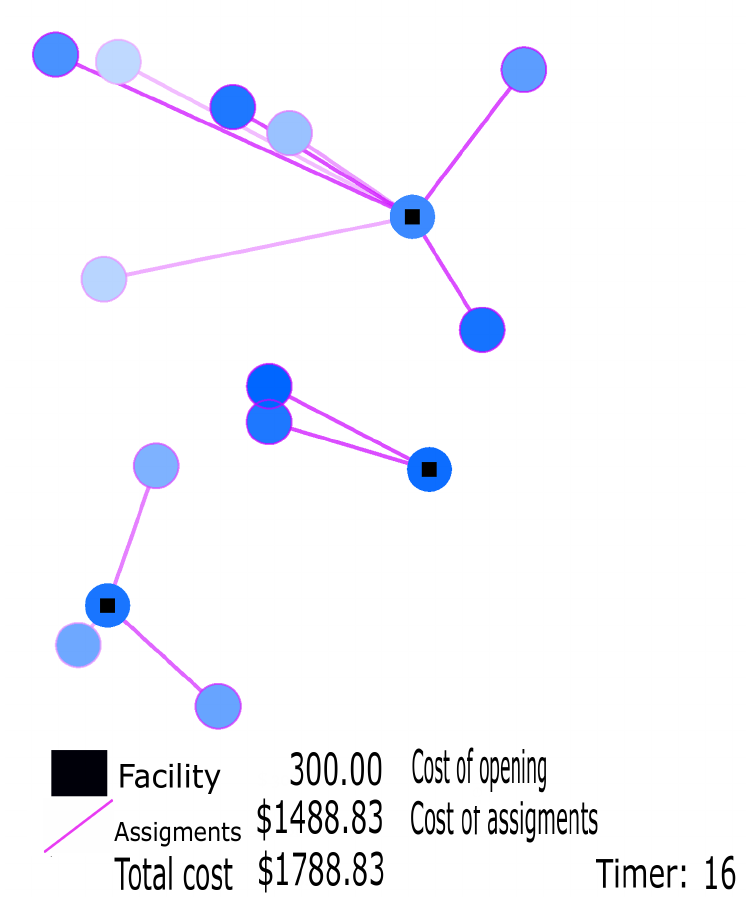
Figure 2. User interface for the Facility Location Problem (FLP) game. Circles represent demand centers and squares facilities (note facilities are placed in a demand center. All demand centers are colored in blue; color saturation varies with the demand center weight, representing the level of demand: the lighter the color, the lesser the level. Assignments between a demand center and a facility are represented by a straight line connecting